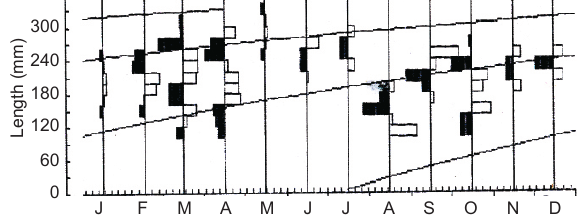
Figure 3. Growth curve of female population of Horabagrus brachysoma from River Periyar by ELEFAN 1 superimposed on the restructured length frequency = 400mm, K = 0.63 yr -1 and Rn = 0.314) diagram (L α